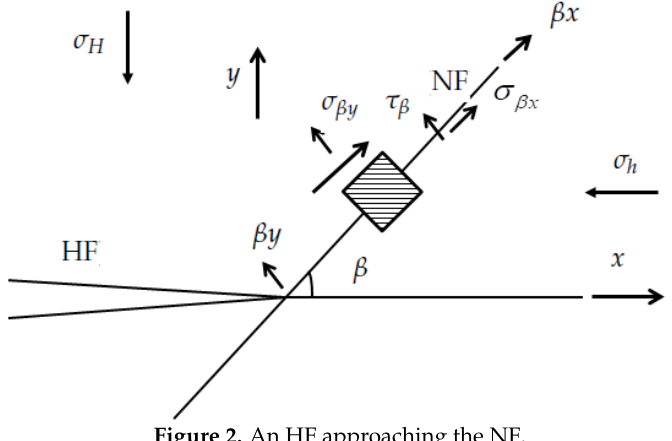
Figure 2. An HF approaching the